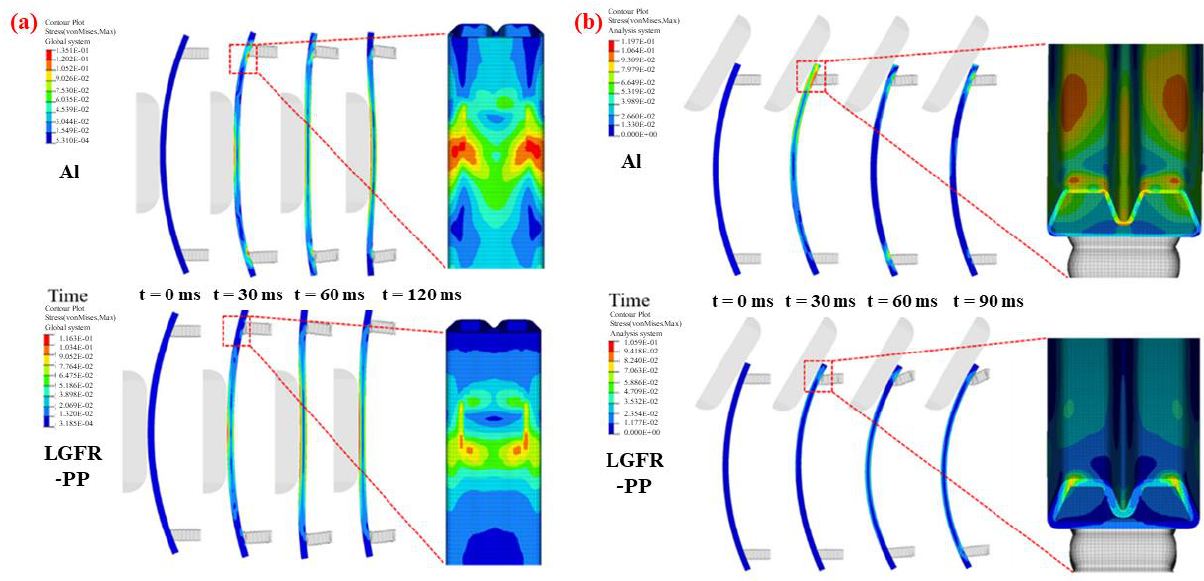
Figure 16. Stress distribution of the LGFR-PP and Al bumper beams under the ( a ) longitudinal and ( b ) angular impact conditions [62]. ( b ) angular impact conditions